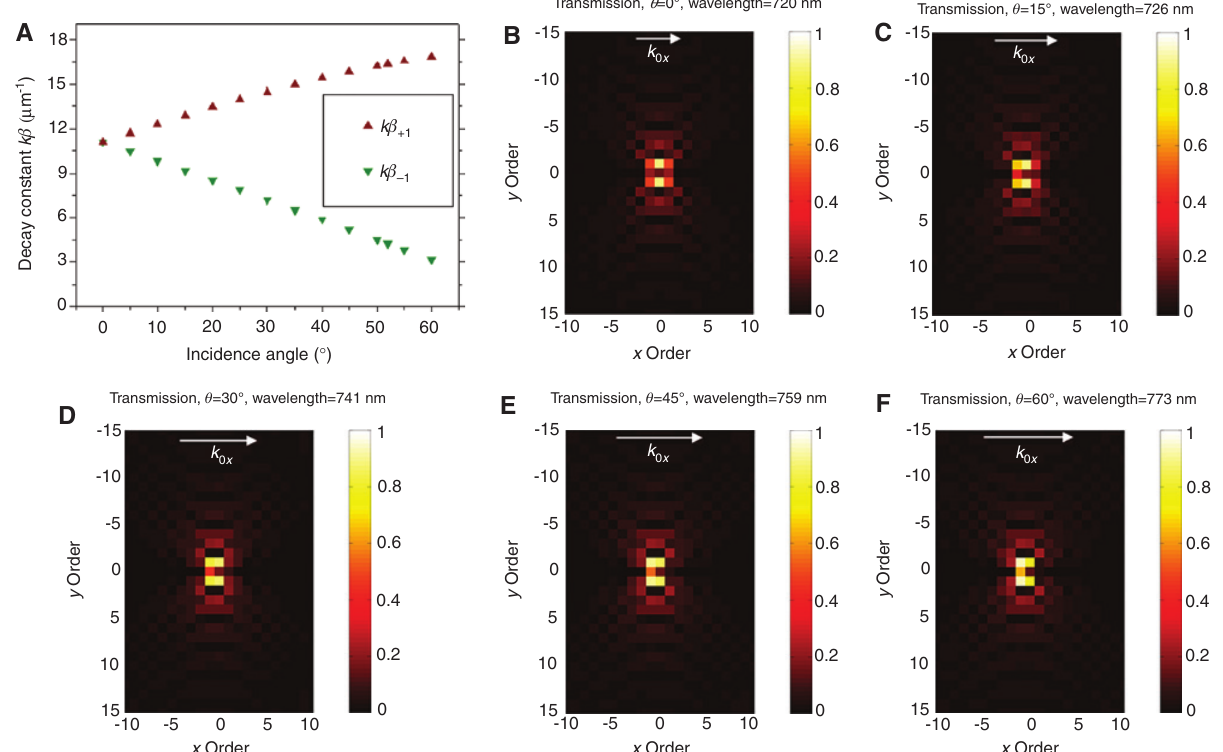
Figure 5: Interpretation of the spectral red-shift of the collective plasmon resonance observed while increasing the incidence excitation angle θ as related to the presence of diffracted evanescent fields in the substrate. (A) Behavior of the decay constant k inc evanescent field ( m = ± 1) as a function of θ ; (B)–(F) maps of the electric field amplitude, at a distance of 50 nm from the substrate, inc calculated for most of the evanescent diffracted orders involved in the CR excitation at different θ